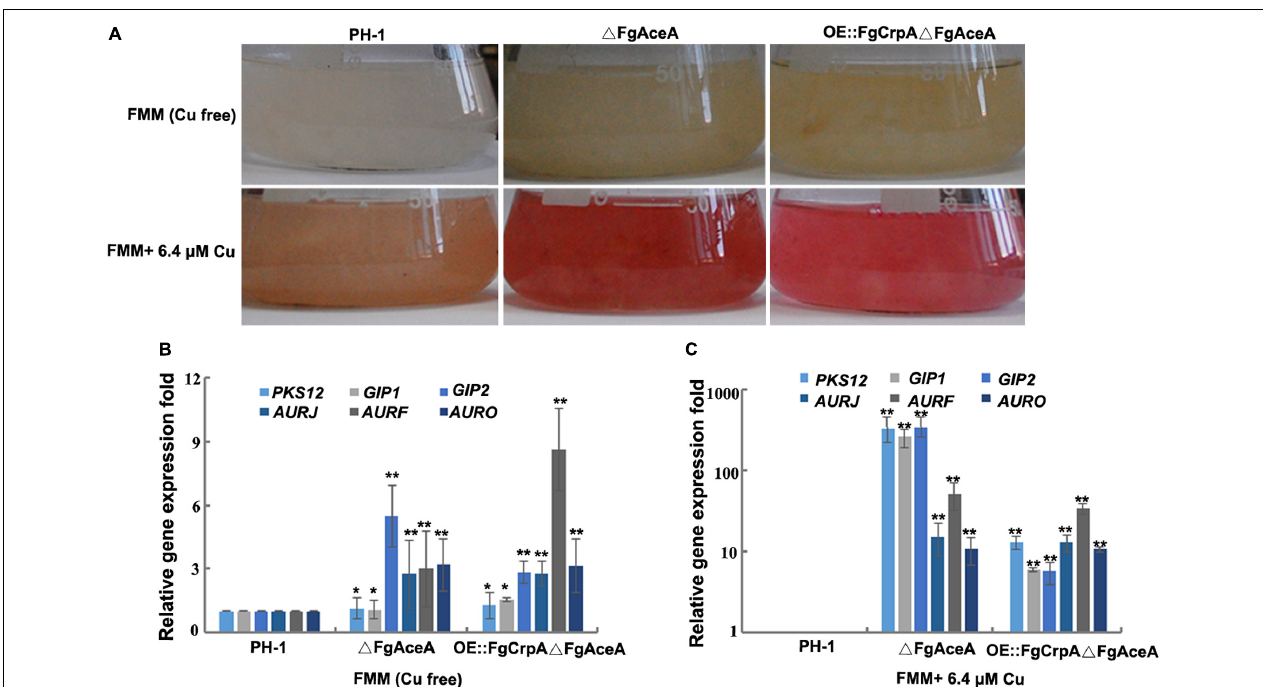
FIGURE 4 | Cu homeostasis affects aurofusarin accumulation in F. graminearum . (A) F. graminearum wild-type strain PH-1, (cid:77) FgAceA, or OE:FgCrpA (cid:77) FgAceA was cultured in 50 ml liquid FMM with or without 5 µ M (trace element level) Cu in a shaker with light at 180 rpm at 25 ◦ C for 4 days. Relative expression of six genes involved in aurofusarin biosynthesis ( PKS12 , GIP1 , GIP2 , AURJ , AURF, and AURO ) in (cid:77) FgAceA or OE:FgCrpA (cid:77) FgAceA when grown in 50 ml liquid FMM with (B) or without 5 µ M (trace element level) (C) Cu in a shaker with light at 180 rpm at 25 ◦ C for 4 days. A t -test was performed to determine significant differences, * p < 0.05, ** p <